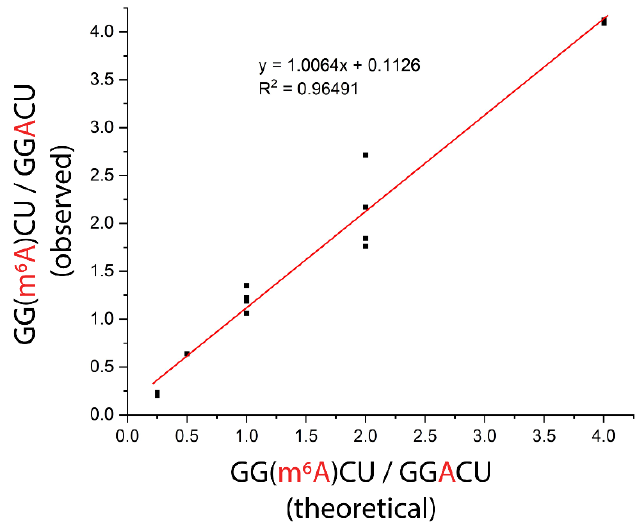
Figure 8. Evaluation of modification stoichiometry for an m 6 A consensus motif (GGACU) in samples prepared with different ratios of modified-to-unmodified RNA. Each sample consisted of controlled amounts of 15-mer RNA standards with either a 5 ′ GGACU or a 5 ′ GG(m 6 A)CU motif. The total amount of RNA was 100 pmol in all samples. The 3 ′ ABzIM-ITO was used for nuclease protection prior to MALDI-MS. Replicates for different stoichiometries were as follows: 1:4 ( n = 2), 1:2 (n = 2), 1:1 ( n = 4), 2:1 ( n = 4), and 4:1 ( n = 2).